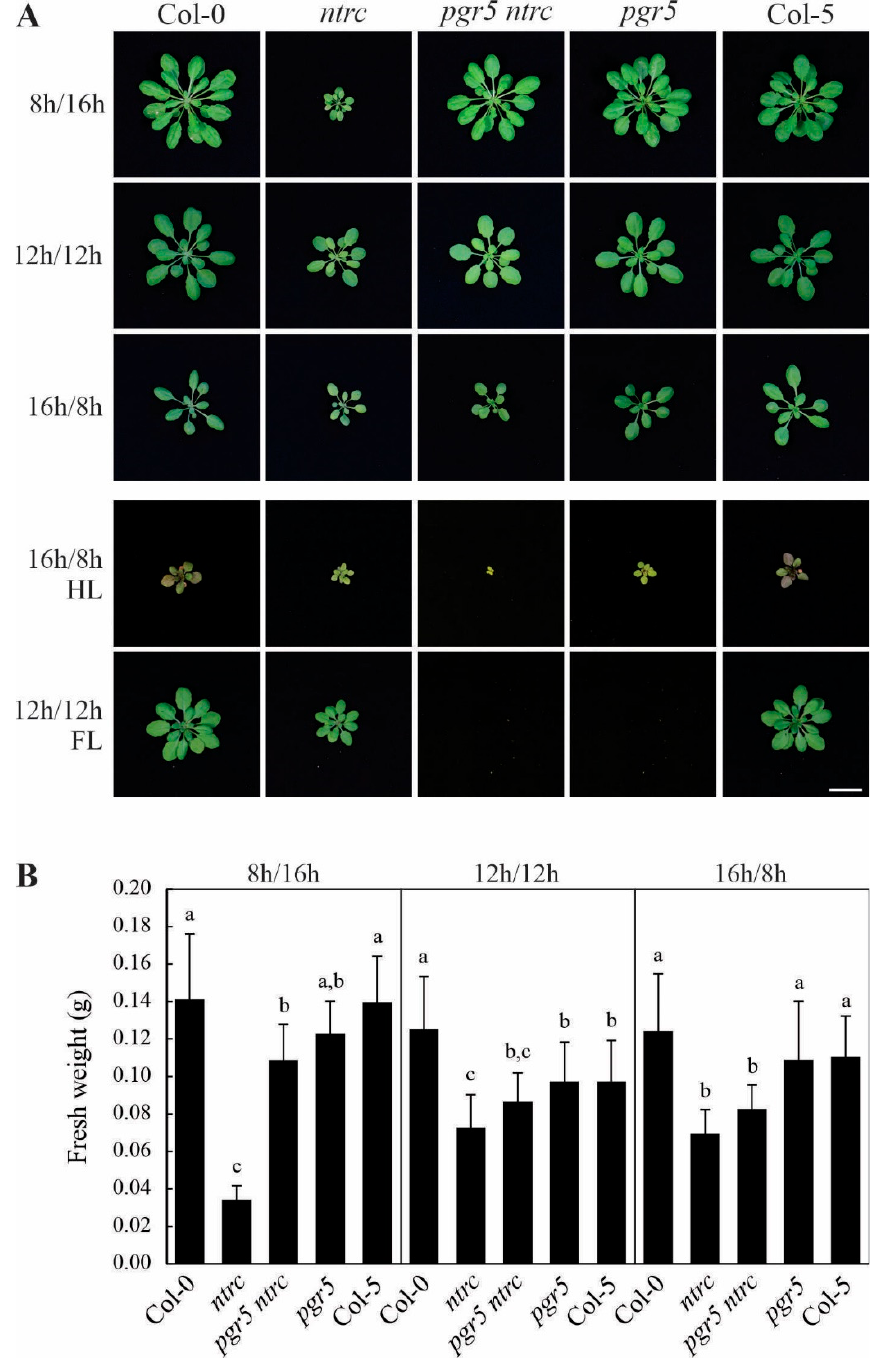
Figure 1. The retarded growth phenotype of ntrc is suppressed by pgr5 under short-day conditions. ( A ) Growth phenotypes of wild type (Col-0 and Col-5) and mutant ( ntrc , pgr5 and pgr5 ntrc ) plants grown on different photoperiods (100 µmol photons m − 2 s − 1 ): 8 h light/16 h dark (short-day, 6-week-old plants), 12 h light/12 h dark (5 weeks old), 16 h light/8 h dark (long-day, 3 weeks old), and under lighting conditions: high light (HL, 500 µmol photons m − 2 s − 1 , 2 weeks old) and fluctuating light (FL, 50 µmol photons m − 2 s − 1 for 1 min and 500 µmol photons m − 2 s − 1 for 5 min, 5 weeks old). The scale bar at the bottom indicates 1 cm. ( B ) Fresh weight averages of plants grown as in ( A ). Error bars correspond to SDs for n ≥ 10. Letters indicate significant differences, as assessed with the Tukey test and a confidence interval of 95%.